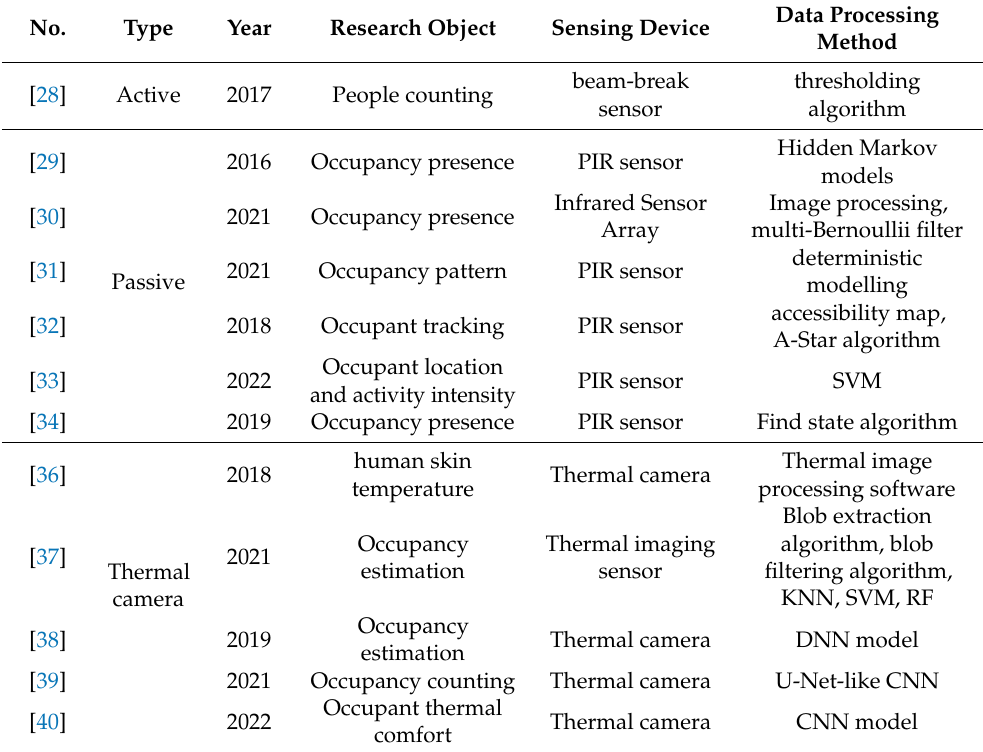
Table 2. The list of references for infrared-based sensing